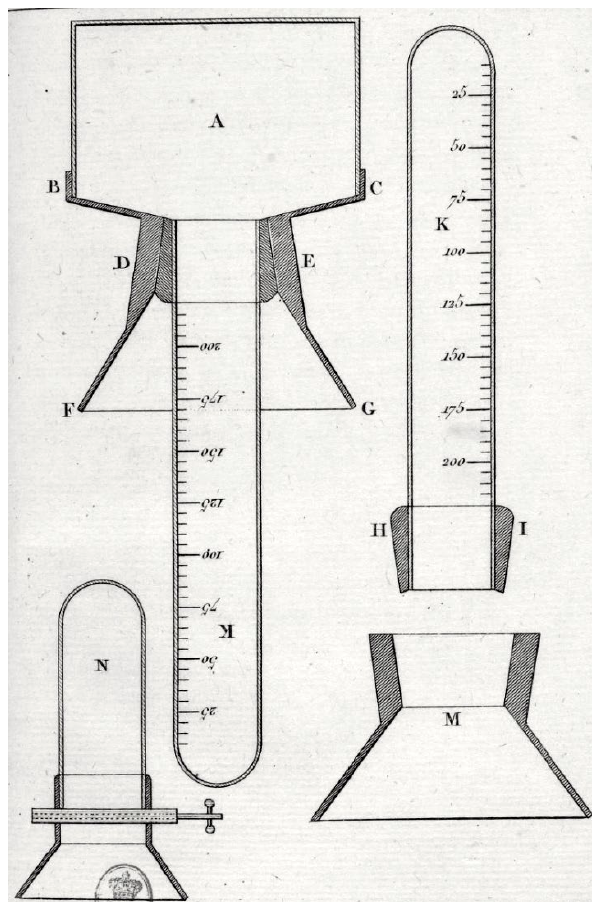
Figure 5. Gay-Lussac’s nitrous gas eudiometer. From Mémoires